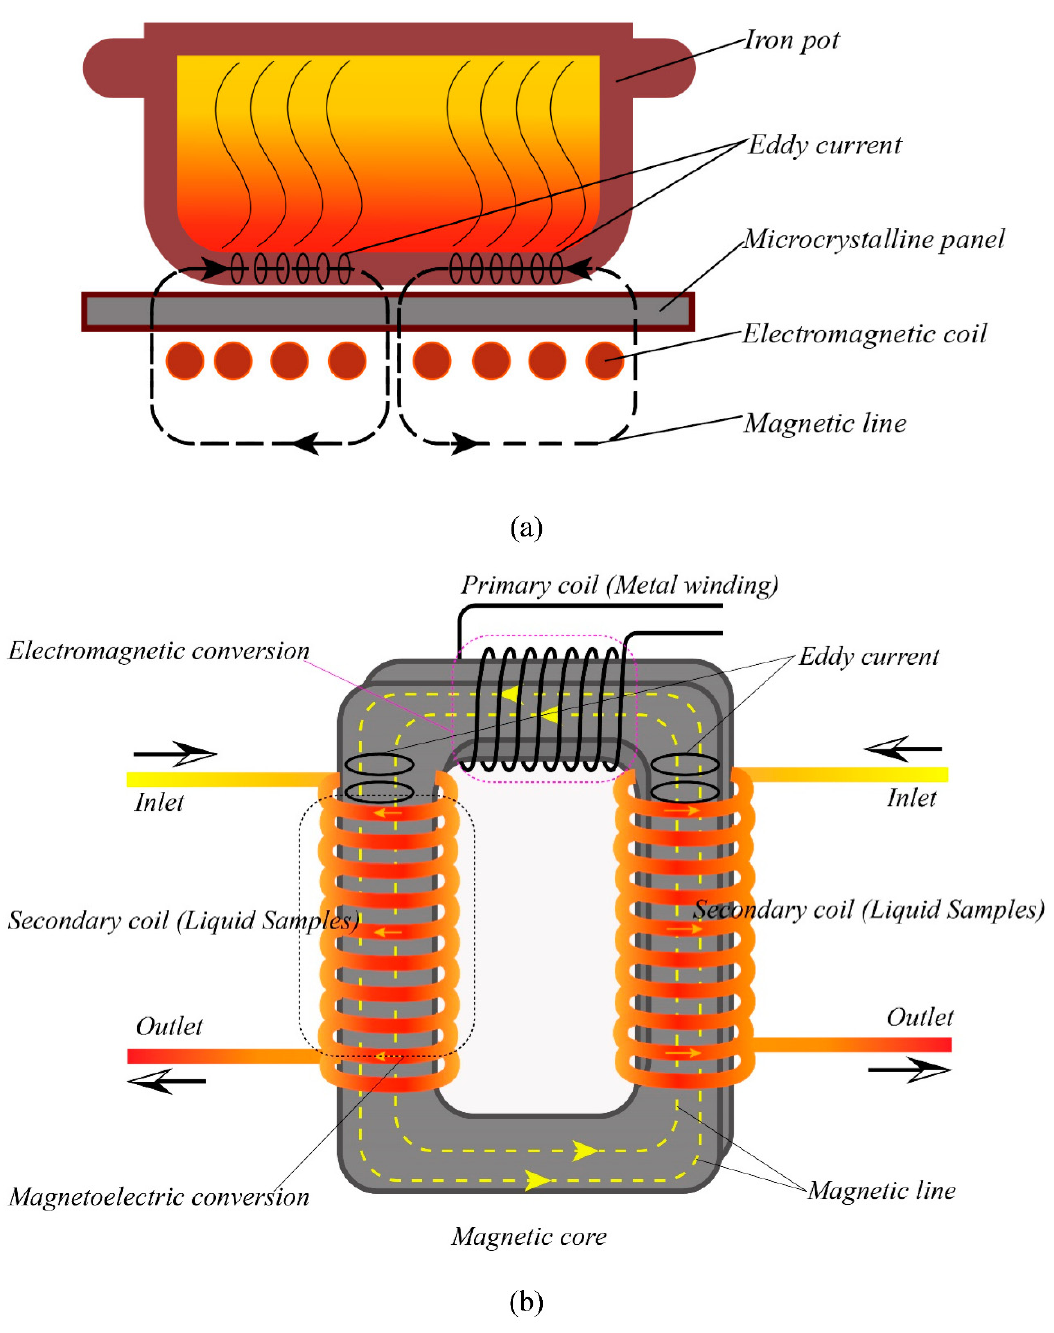
Figure 1. ( a ) The heating principle of induction cooker; ( b ) The heating principle of magneto-induced electric field.